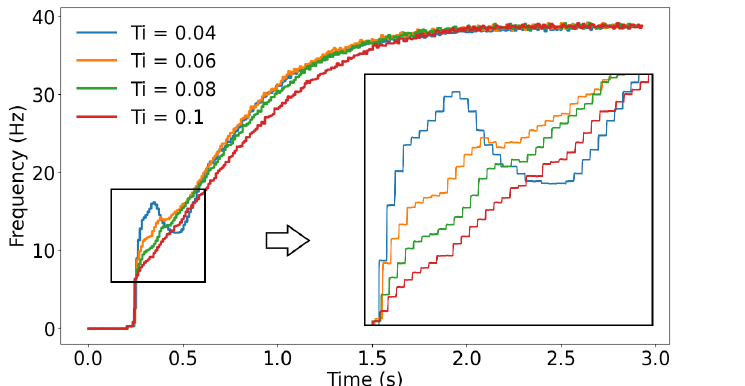
Figure 21. System frequency signal at the starting phase with K p = 1 and different T i